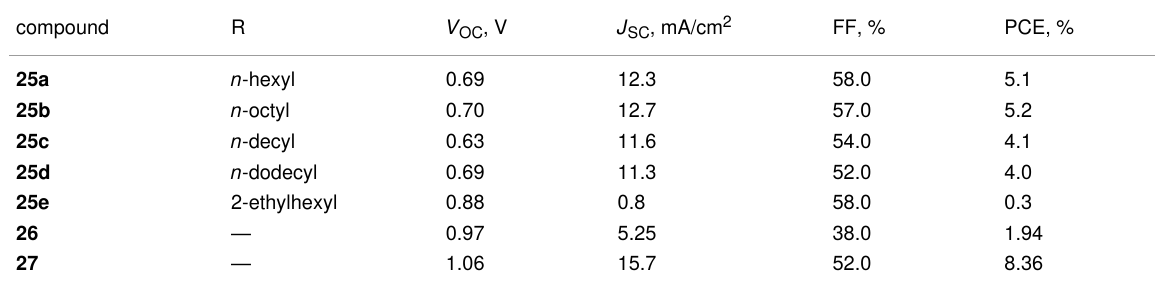
Table 5: Photovoltaic characteristics of OSCs based on polymers 25 – 27 .